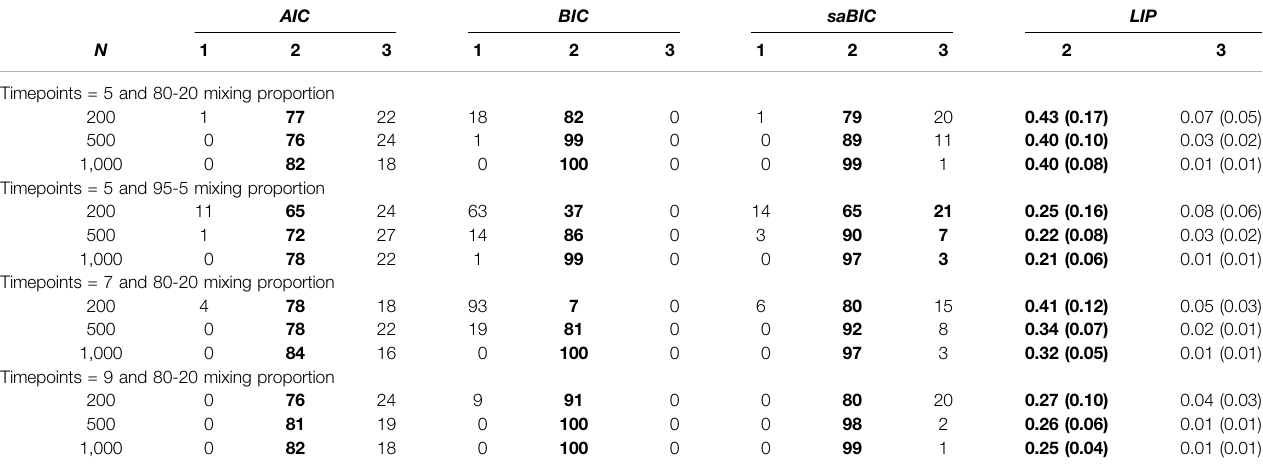
TABLE 3 | Model selection in growth mixture modeling structures with a three standard deviation difference in the intercepts from Grimm et al. (2013) and Associated LIP values. AIC BIC saBIC LIP